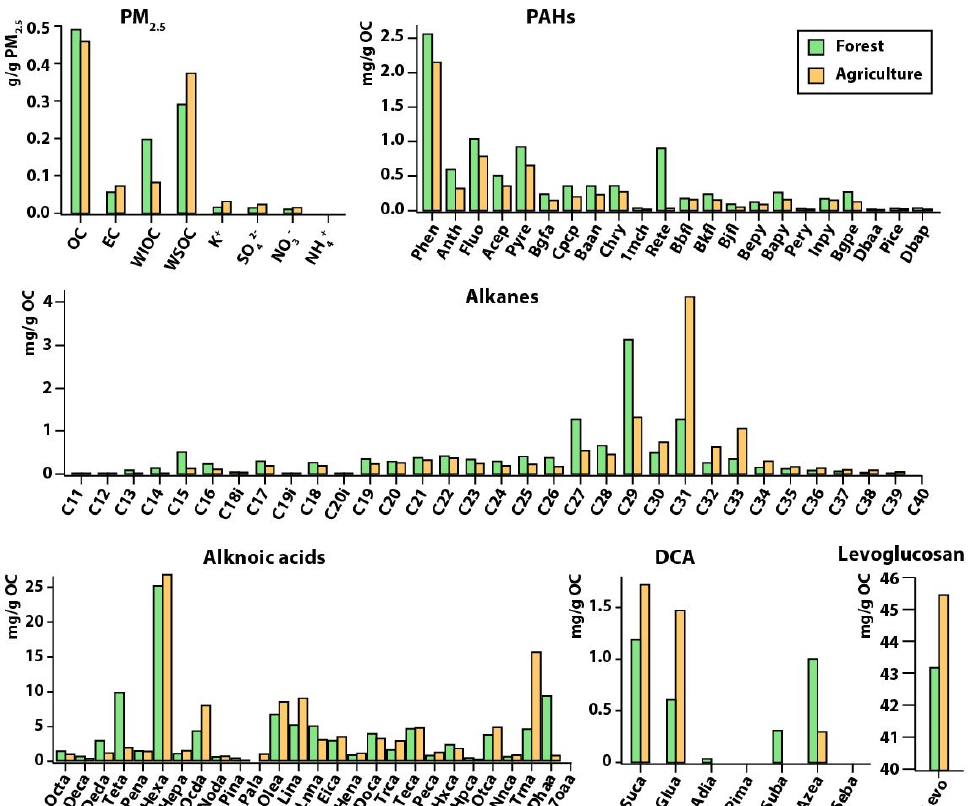
Figure 4. Comparison of concentrations of the main components of PM 2.5 from forest burning and agriculture burning.